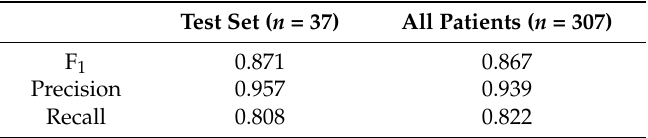
Table 3. Weighted average F 1 , precision, and recall values for all data